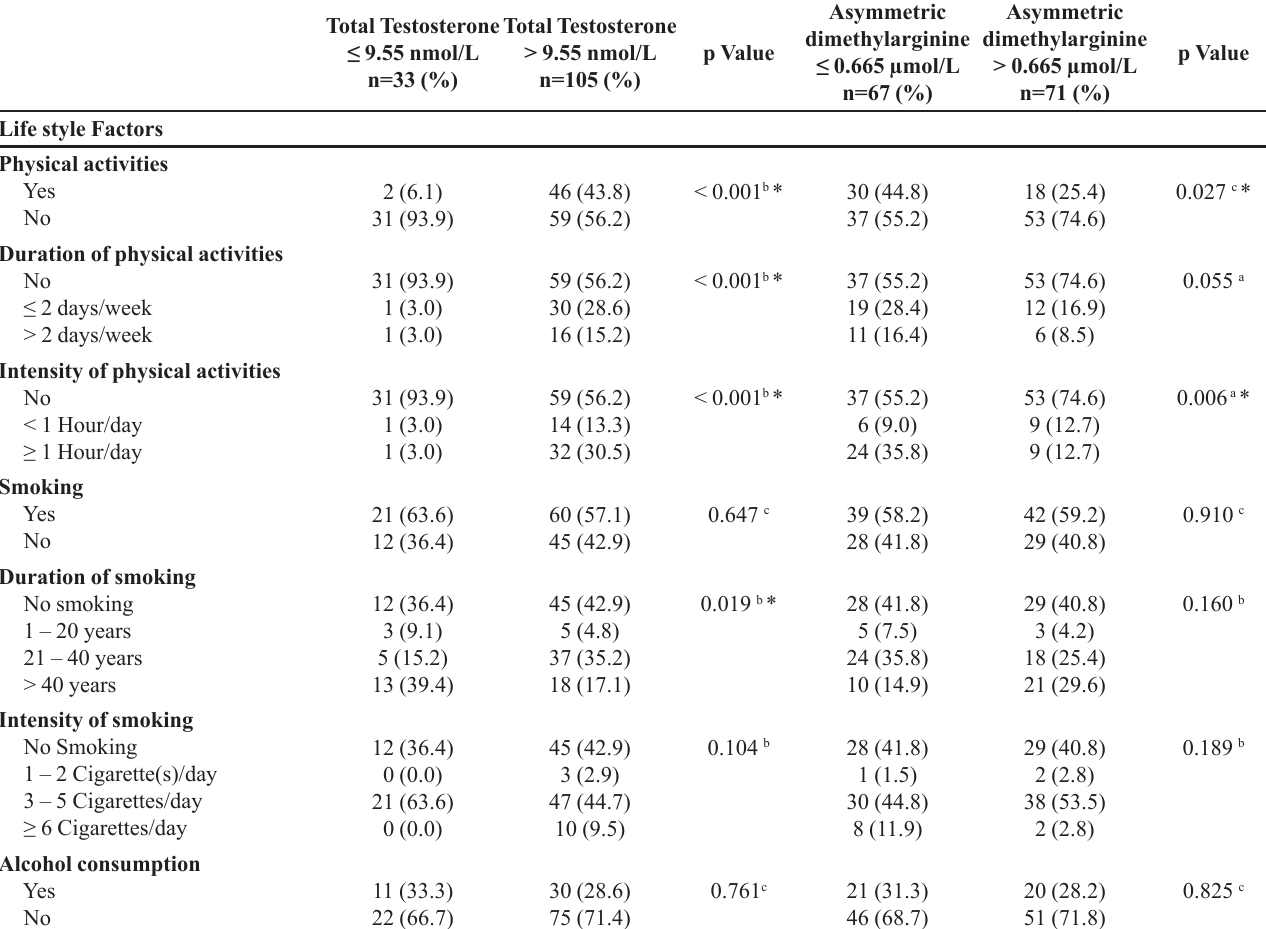
TABLE II - Association of Demographic, Clinical, and Lifestyle factors with Biomarkers level (TT and ADMA), n= 138